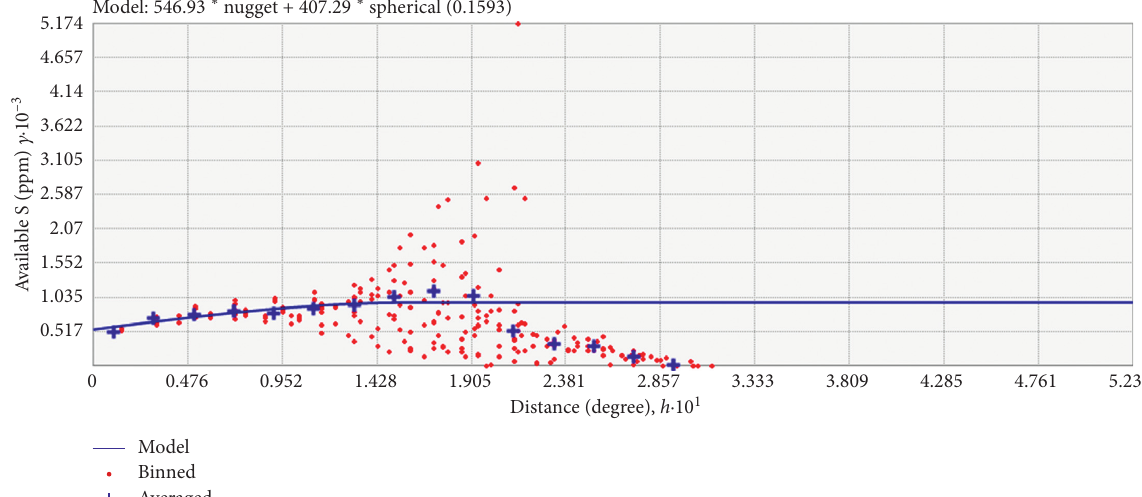
Figure 4: Fitted semivariograms illustrating the strength of statistical correlation between major soil nutrients: (a) available Sulfur (Av S) in the study area.